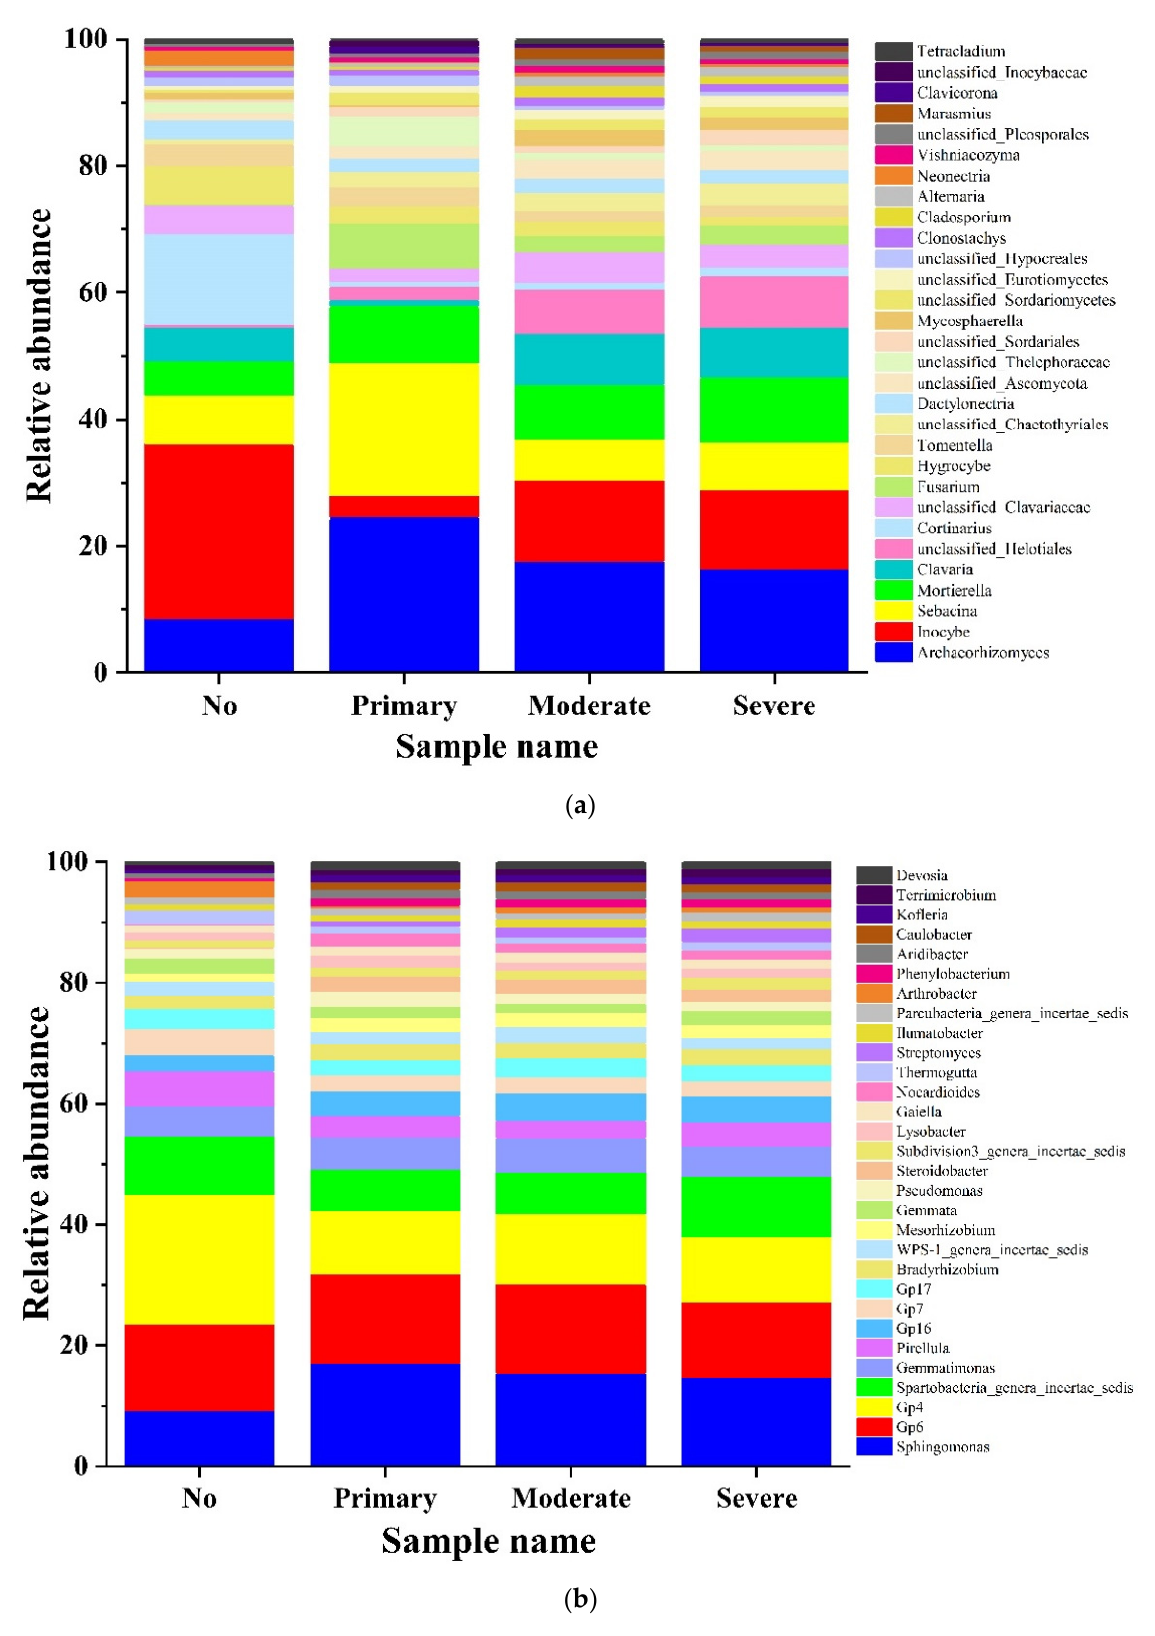
Figure 4. Genus composition of fungi ( a ) and bacteria ( b ).